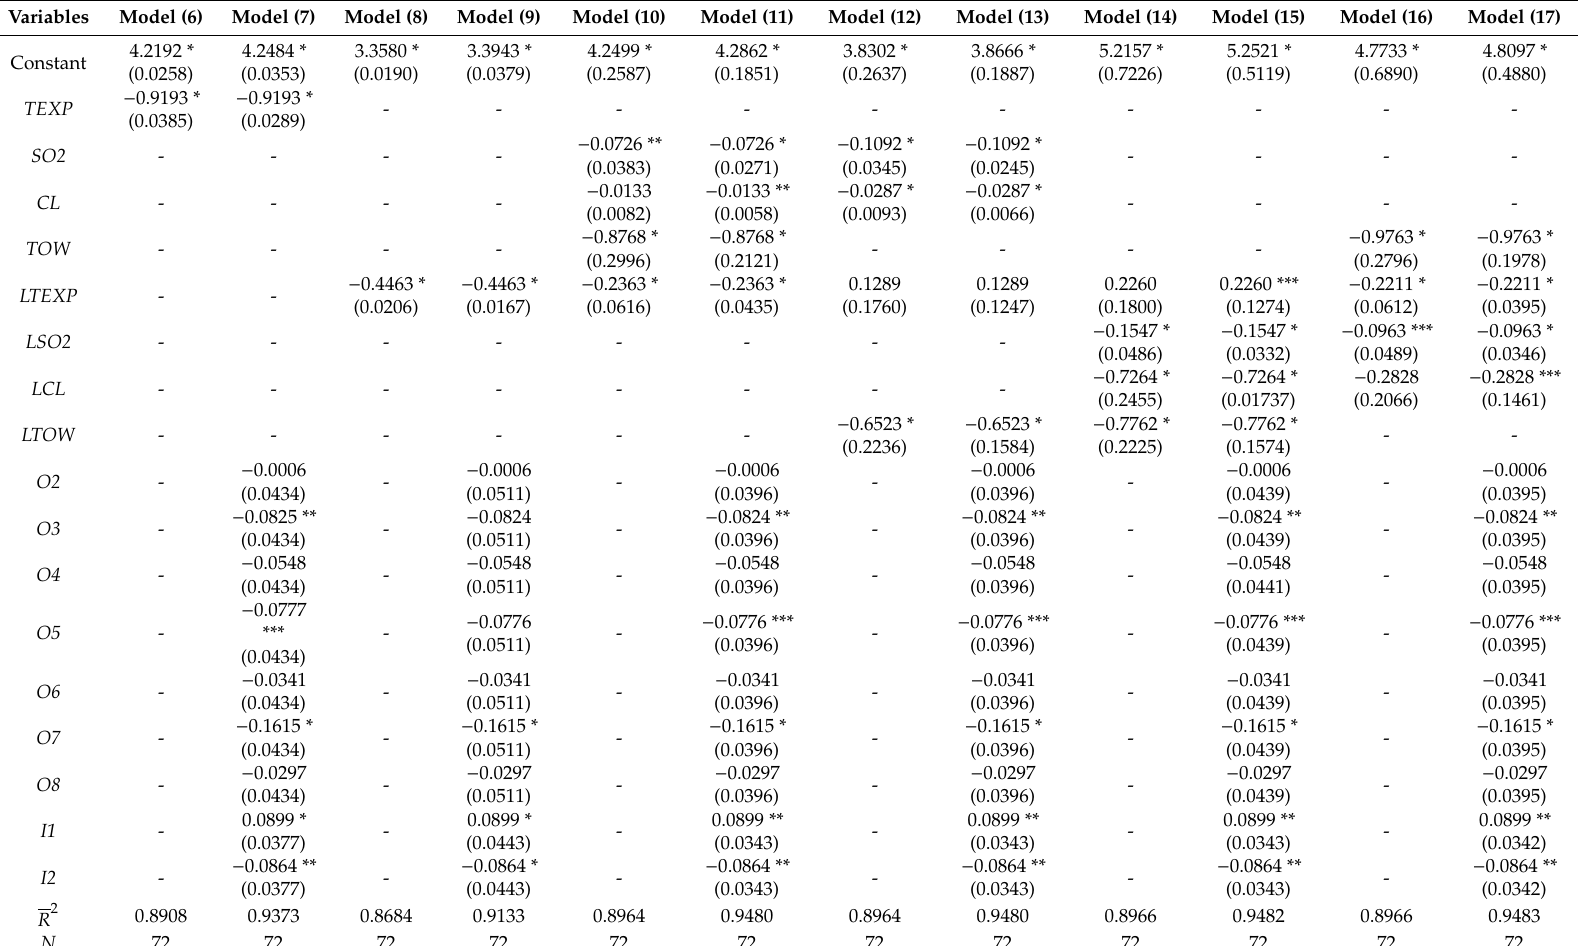
Table 6. Values of the constants k i , δ i and γ i obtained from the application of models